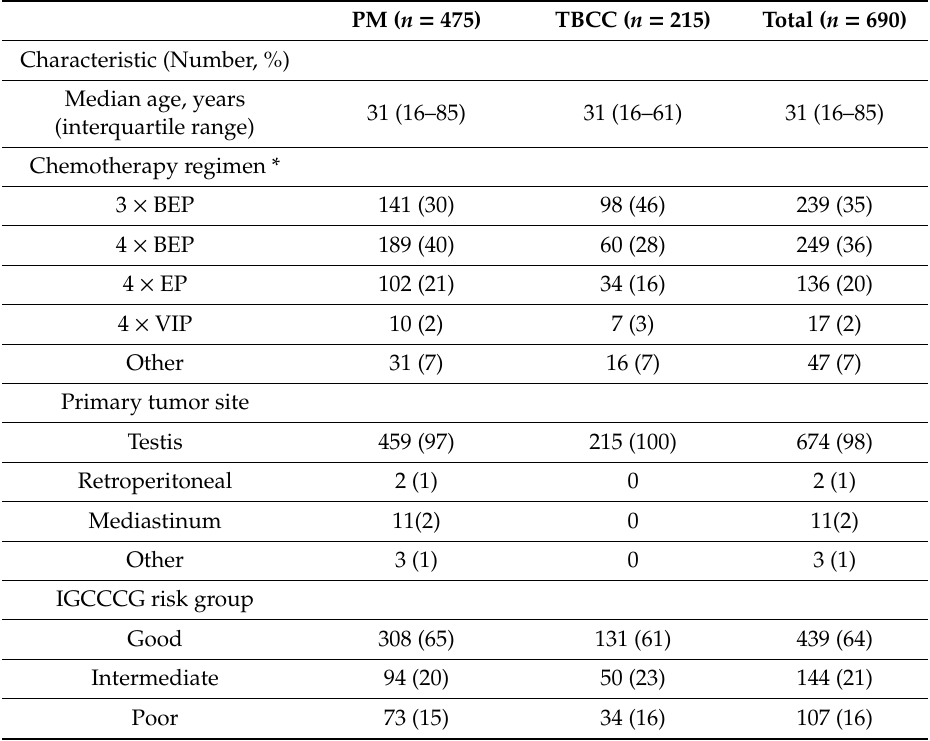
Table 1. Baseline patients’ clinical characteristics.